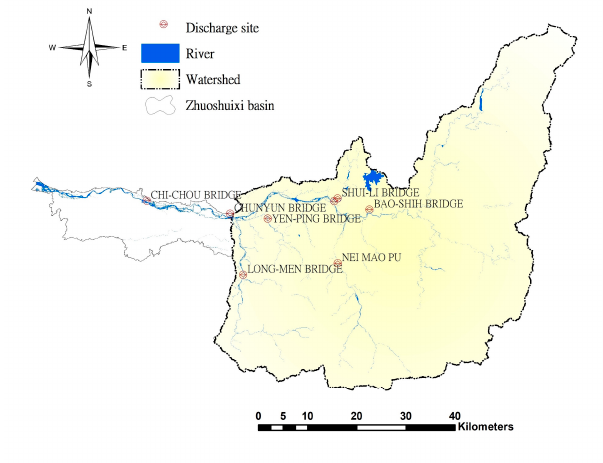
Figure 6. Location of the flow station. Table 4. Observation and estimation of the maximum discharge events in each year.